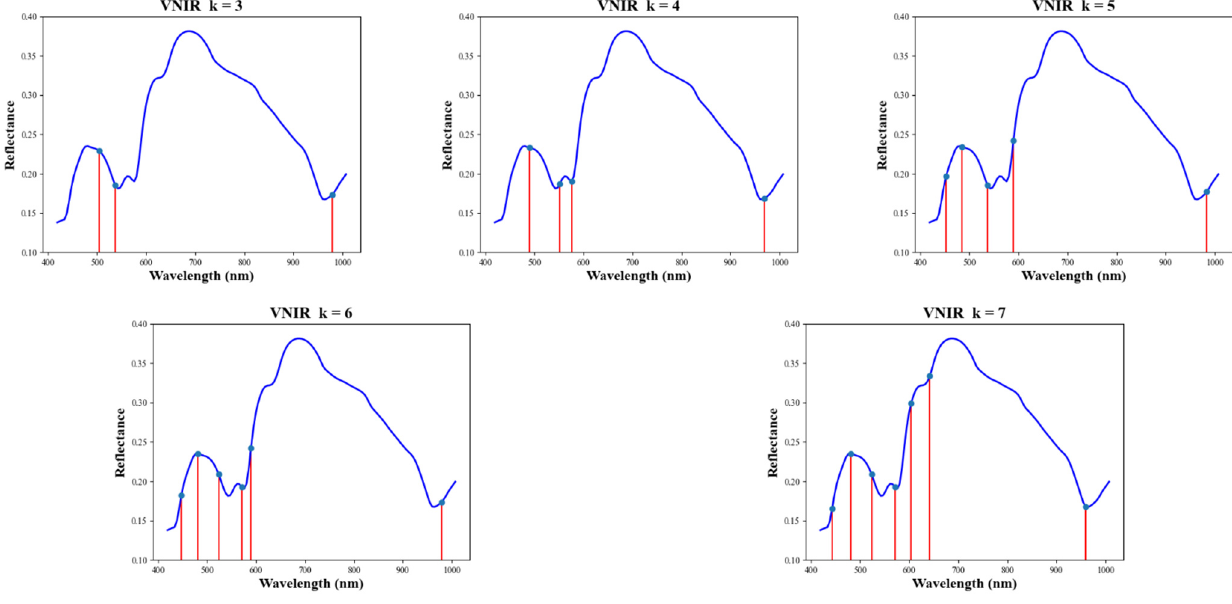
Figure 8. Average fluorescence spectrum for one of the red snapper fillets with the optimal k = 3, 4, 5, 6, 7 wavelength selections.